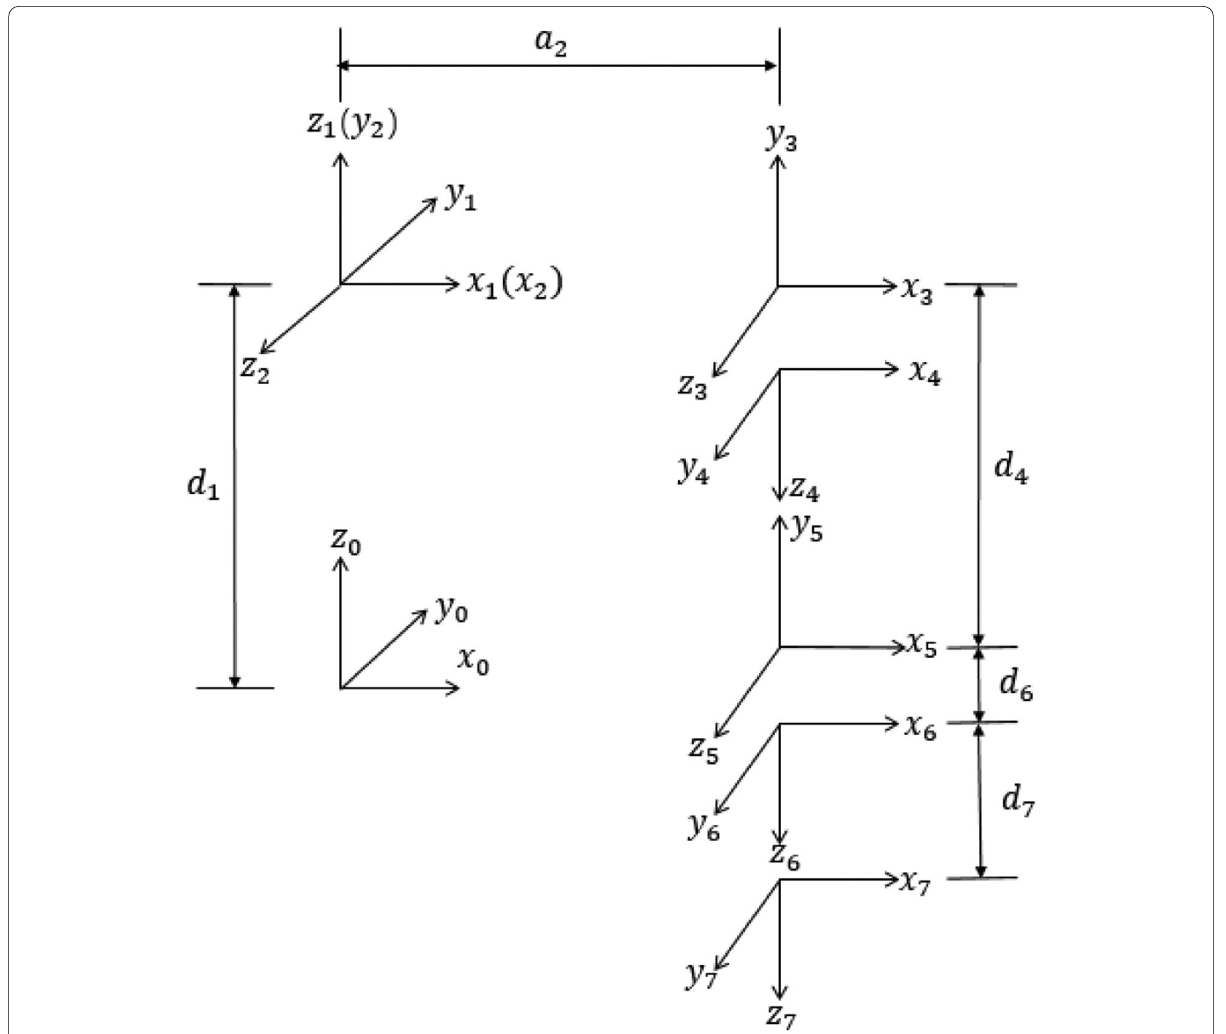
Figure 2 Modified DH coordinate system of serial